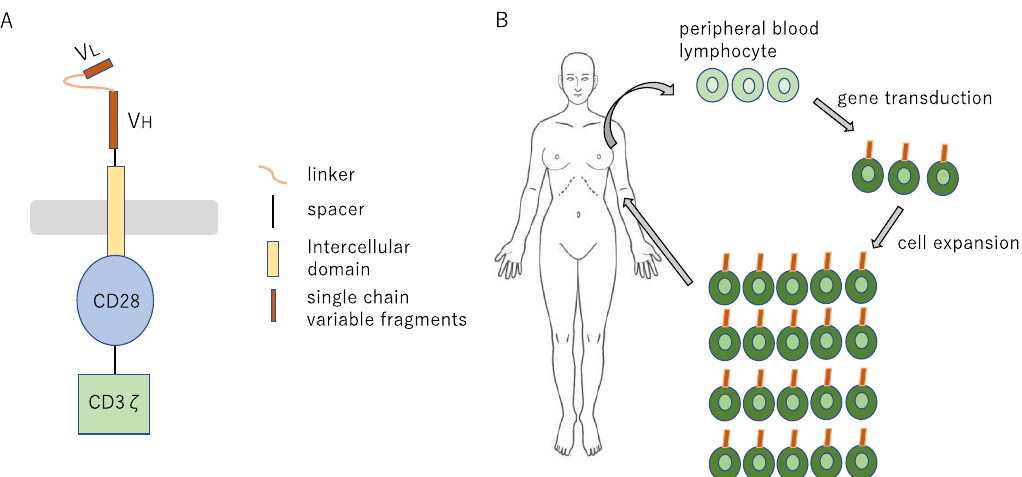
Figure 13. Cell therapy concept diagram ( A ) The Fab portion, corresponding to the surface antigen of the target tumor cell, is utilized in the form of single-chain antibody, and the signal transduction site (CD3ζ) of the T cell receptor and the CD28 (a co-stimulatory molecule for T cells) are fused to it, to yield CAR; ( B ) CAR is introduced by means of gene transfer with a retrovirus vector into T cell, to yield CAR-T cell. The T cell collected from the patient is genetically modified ex vivo, to yield CAR-T cell, which is infused into the patient after expanded culture.